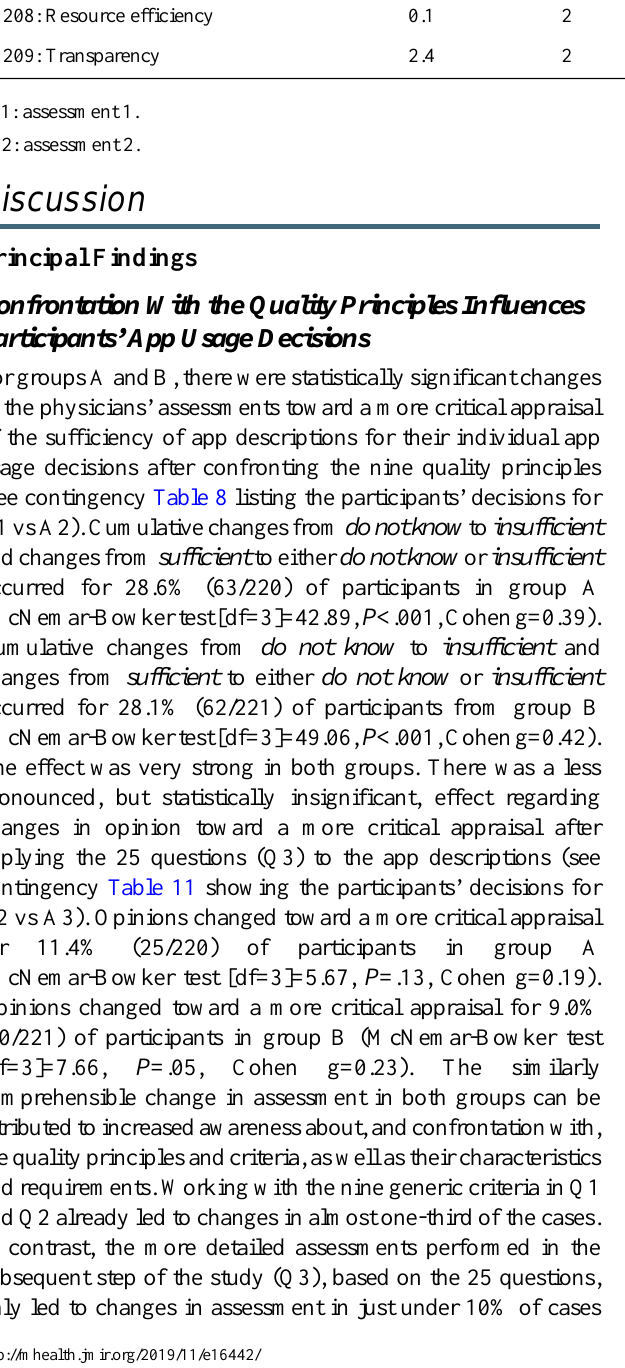
Group BGroup AQuality principle (as listed in questionnaire